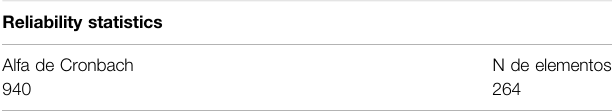
TABLE 2 | Cronbach ’ s Alpha test results for the group of experts.